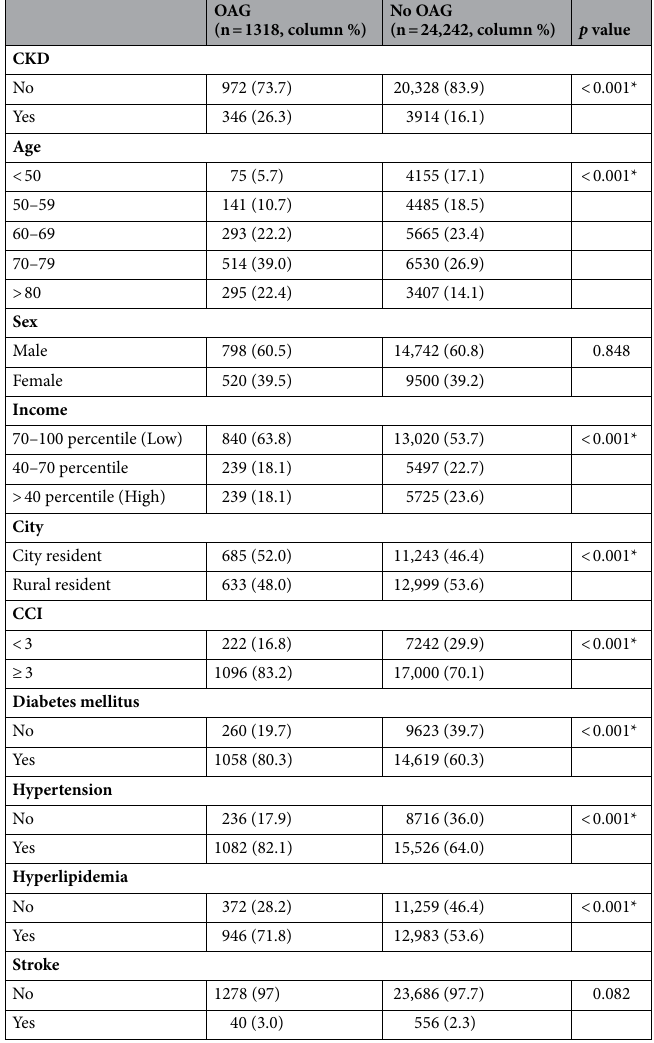
Table 1. Demographic characteristics of study population. * p < 0.05. OAG , open-angle glaucoma; CKD , chronic kidney disease; CCI , Charlson comorbidity